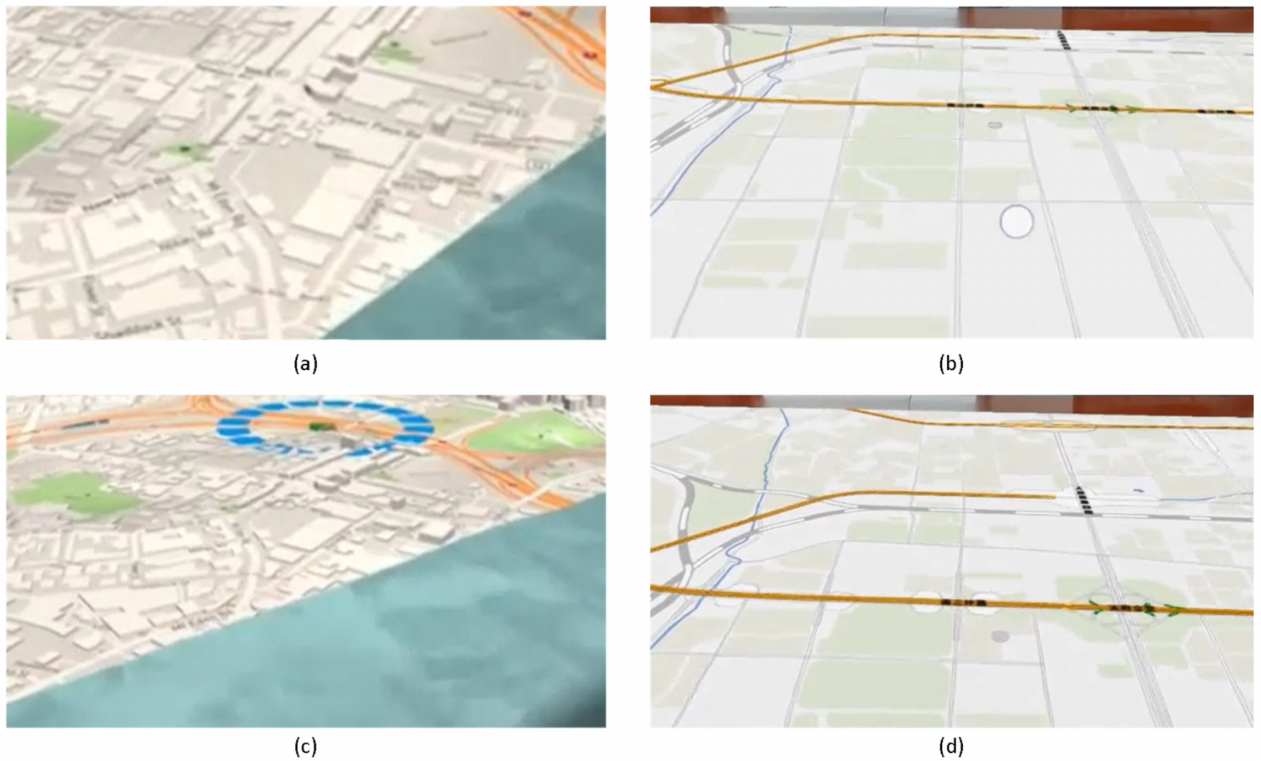
Figure 9. Comparison of the delay of the two methods in the case of fast panning operations: ( a ) before fast pan (Mapbox), ( b ) before fast pan (our method), ( c ) after fast pan (Mapbox), ( d ) after fast pan (our method).